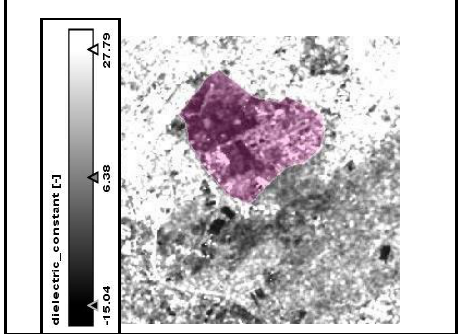
Figure 3. Dielectric constant using Dubois model